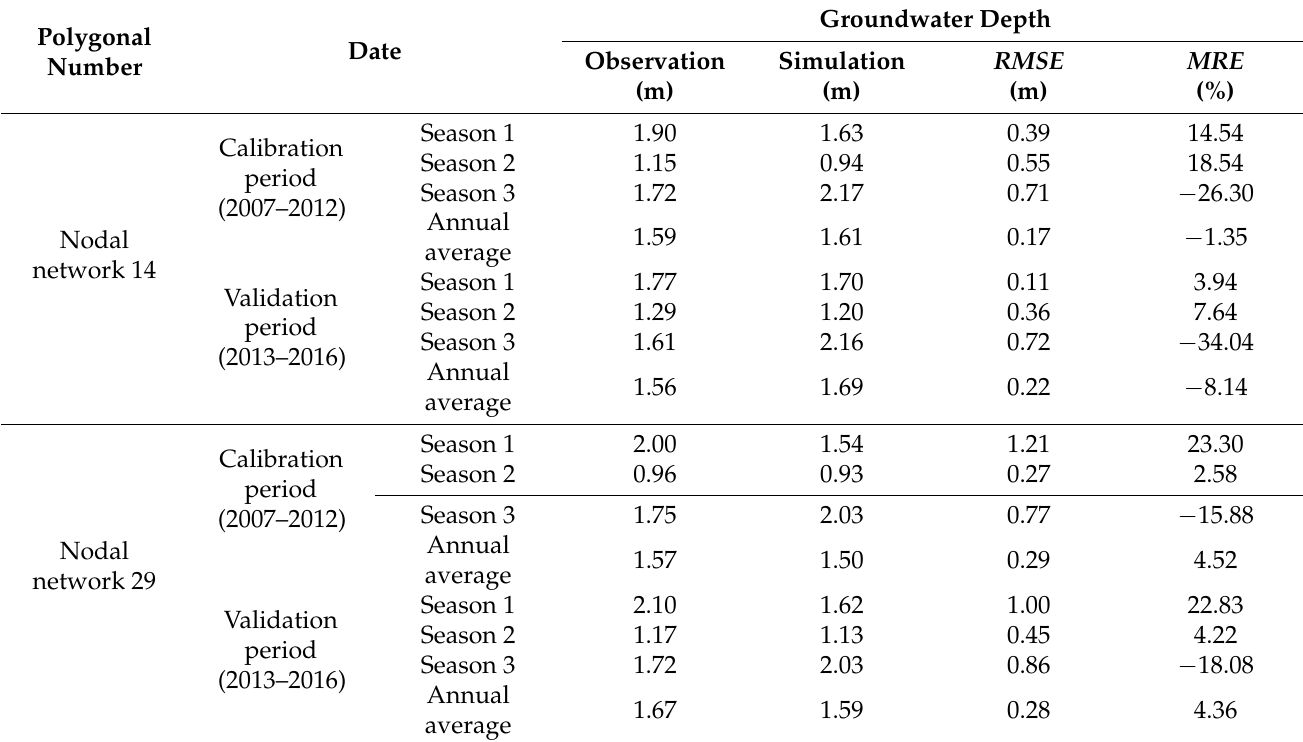
Table 3. Comparison of measured and simulated groundwater depth.